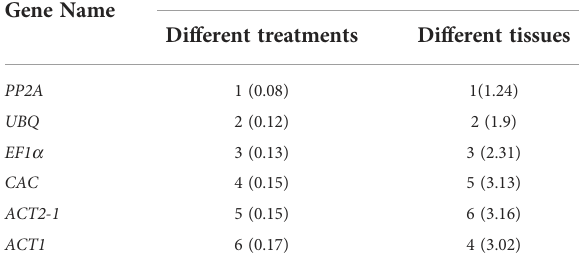
TABLE 1 Ranking order of reference genes determined by NormFinder under drought